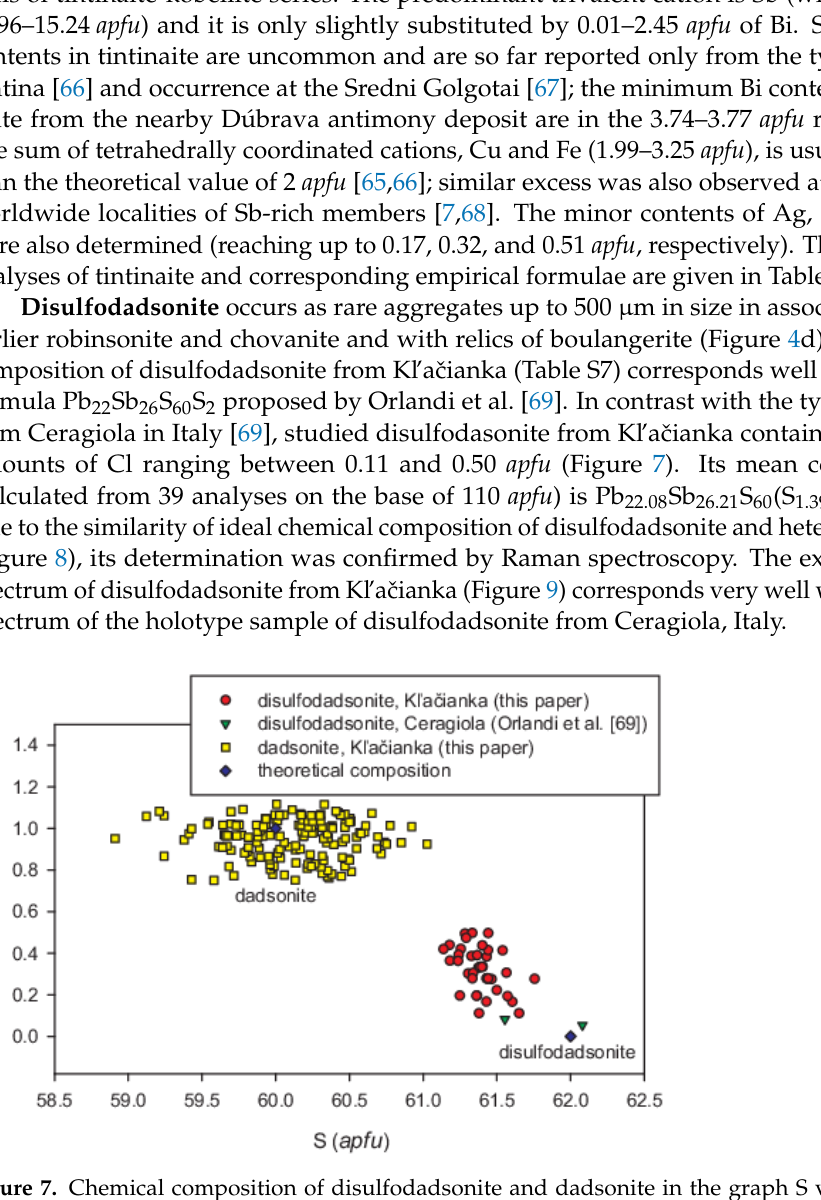
Figure 7. Chemical composition of disulfodadsonite and dadsonite in the graph S vs. Cl (at.%); theoretical composition: disulfodadsonite Pb 22 Sb 26 S 60 S 2 ; dadsonite Pb 23 Sb 25 S 60 Cl.